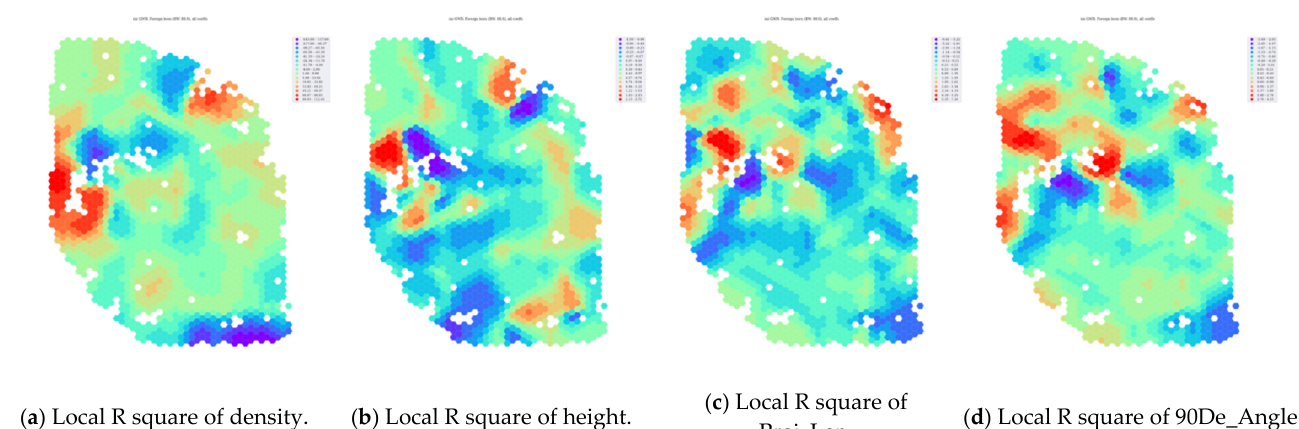
Figure 6. Influential areas and relative intervention methods: ( a ) density method; ( b ) height method; ( c ) projection length method; ( d ) orientation of the viewpoints direction method. Table 8. OLS and GWR correlation of the selected